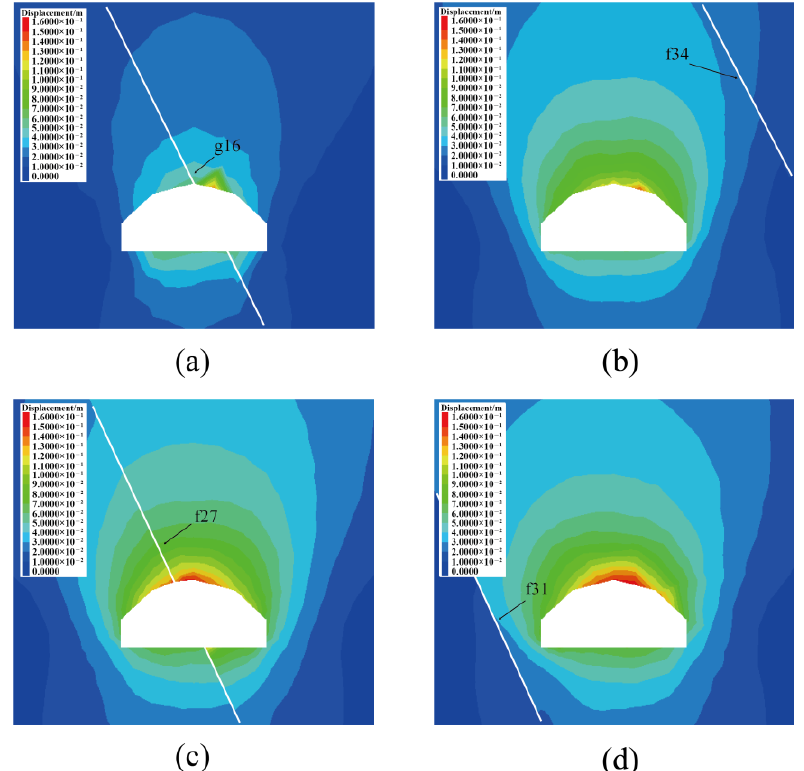
Figure 12. Displacements at the intersection of structural planes and the diversion tunnel trunk: ( a ) Stake K0 + 607; ( b ) Stake K0 + 582; ( c ) Stake K0 + 542; ( d ) Stake K0 + 518.